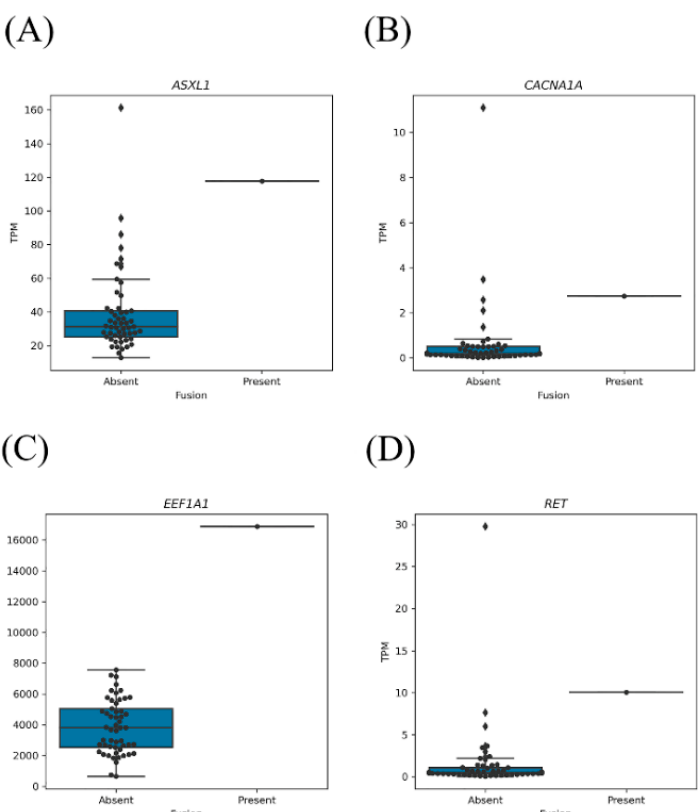
Figure 2. Expression levels of genes present in fusions; expression outliers are shown. ( A ) ASXL1 expression in samples with or without ASXL1 fusion genes. ( B ) CACNA1A expression in samples with or without CACNA1A fusion genes. ( C ) EEF1A1 expression in samples with or without EEF1A1 fusion genes. ( D ) RET expression in samples with or without RET fusion